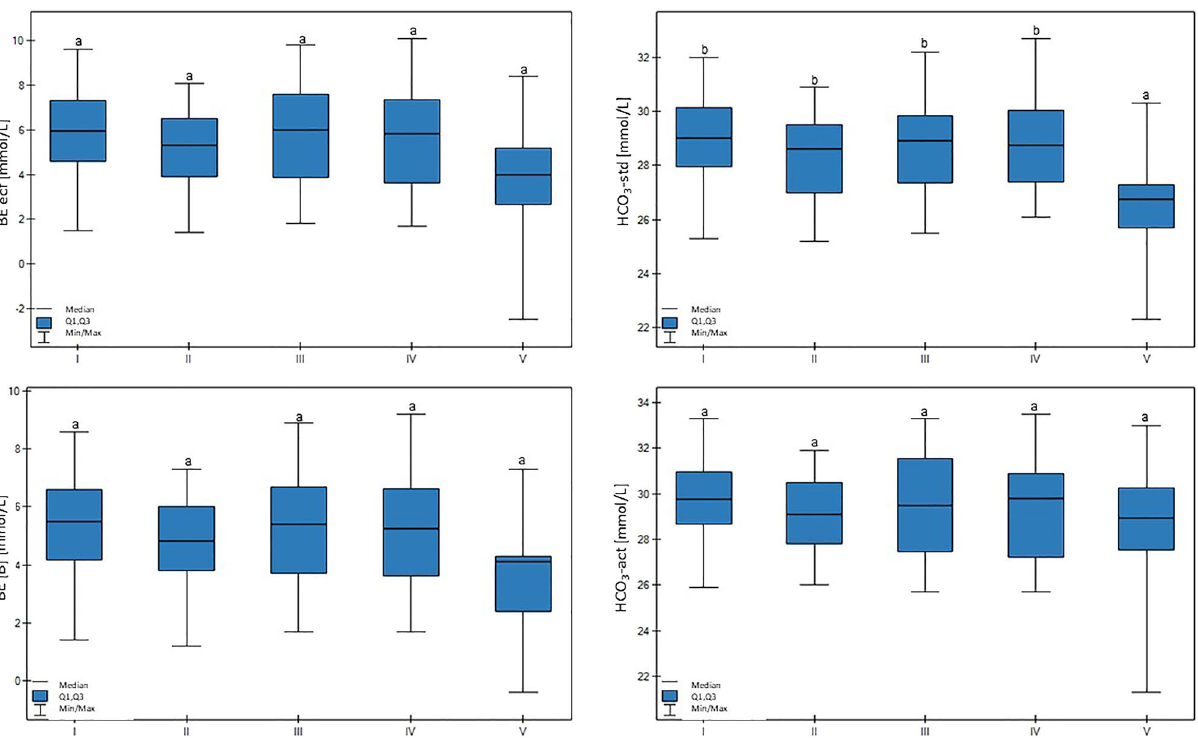
Figure 3. Differences in BE(B) (base excess), BE ecf (base excess of extracellular fluid), HCO 3 − act (actual bicarbonate concentration), and HCO 3 − std (standard bicarbonate concentration) values in cows at different production levels. In the box plots, the upper whisker represents the maximum value; the upper line of the box represents Q3 (upper quartile); the center line inside the box represents the median; the lower line of the box represents Q1 (lower quartile); and the lower whisker represents the minimum value. Groups marked by letters (a–b) differ significantly, p ≤ 0.05. The cows were divided in to five groups: I—44–39 kg milk/cow; II—38–31 kg milk/cow; III—30–26 kg milk/cow; IV—25–20 kg milk/cow; and V—19–17 kg milk/cow, based on mean daily milk